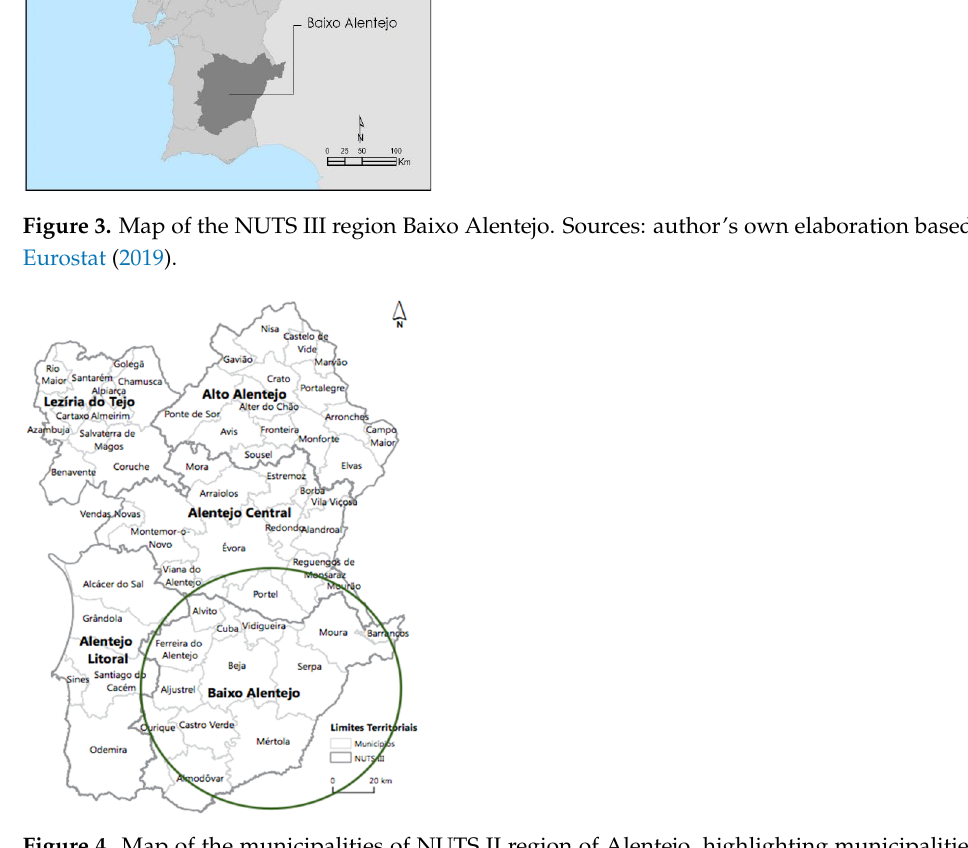
Figure 3. Map of the NUTS III region Baixo Alentejo. Sources: author’s own elaboration based on Eurostat (2019).